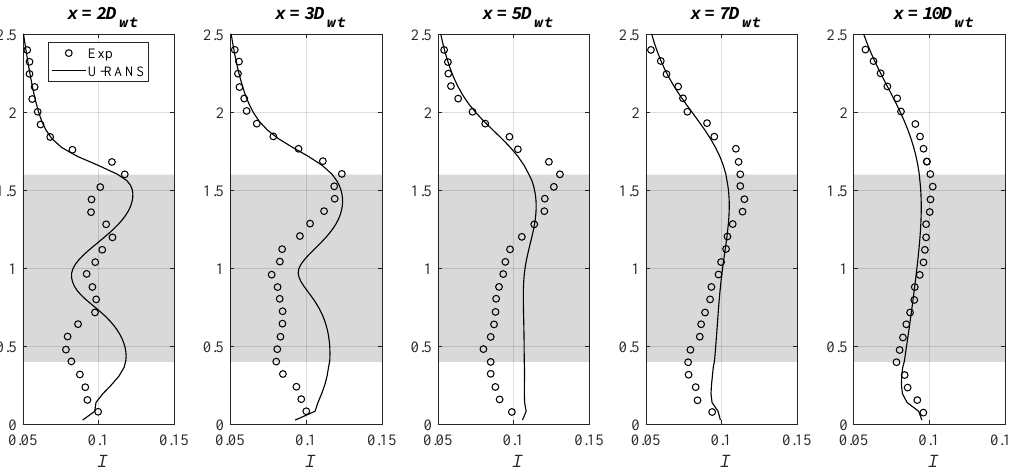
Figure 15. Vertical profiles of turbulence intensity ( I ) at different stream-wise locations downstream of the turbine taken from the midplane (the shaded region depicts the rotor area)